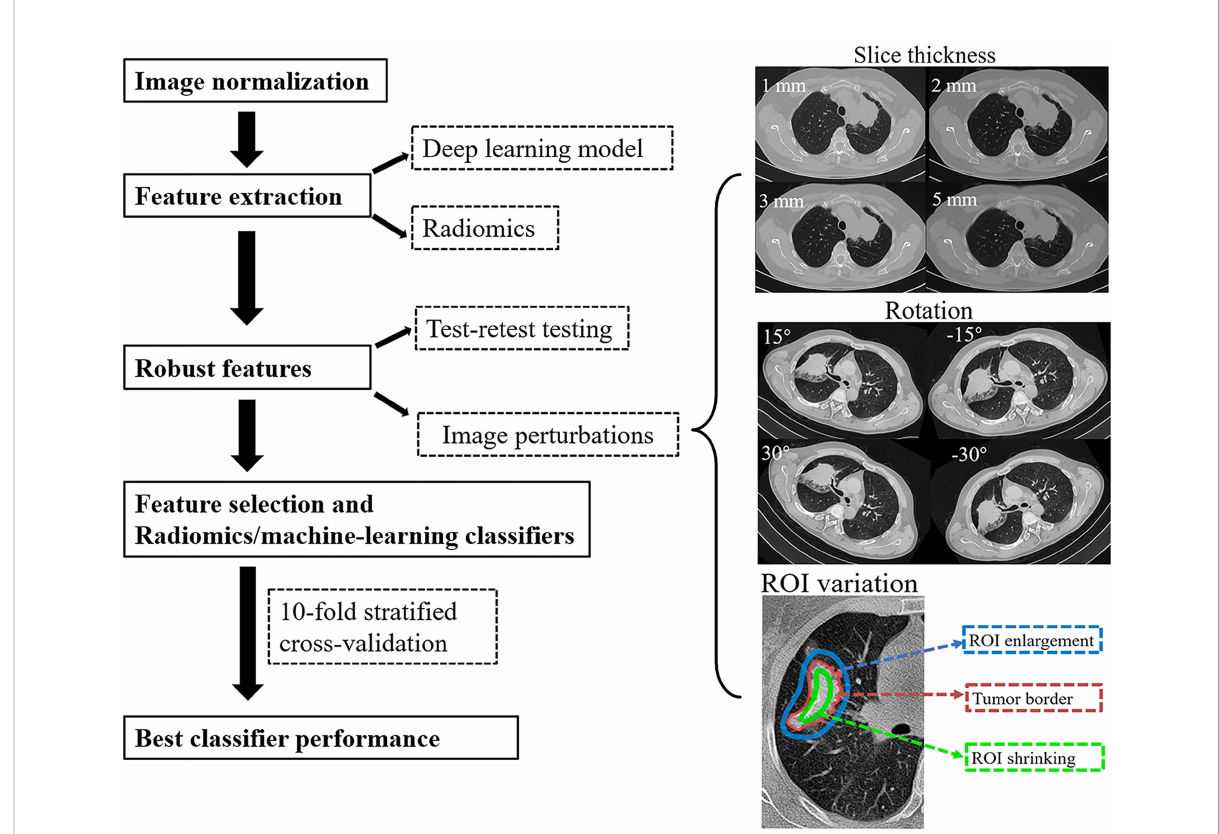
FIGURE 1 The study fl owchart. After pre-processing and tumor segmentation, the images were arti fi cially perturbed. Robust features were evaluated by machine learning (ML)